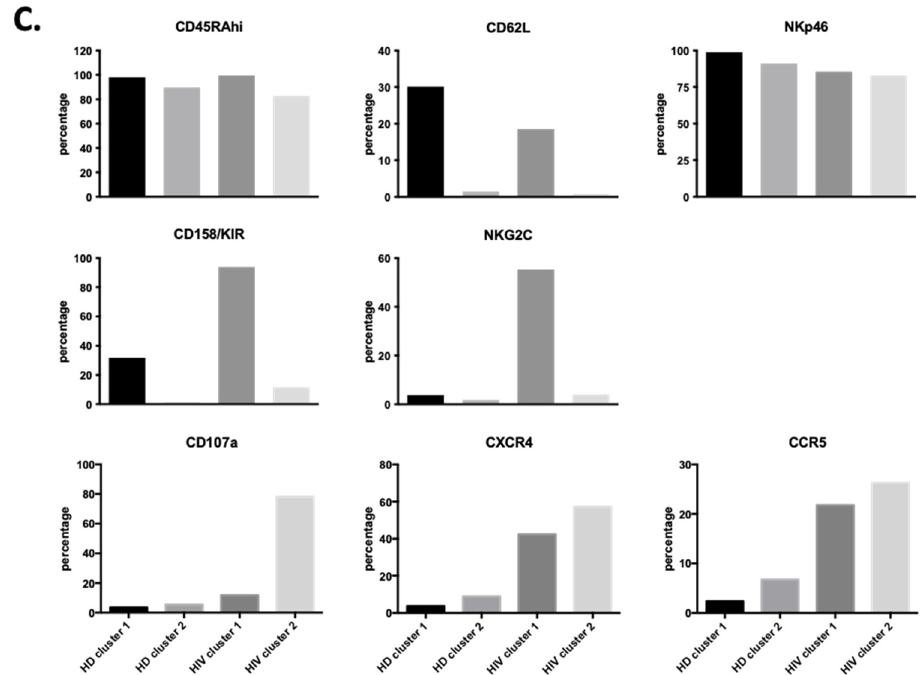
Figure 8. Cluster analysis on CD56negCD16 + NK cells by tSNE mapping in viremic patients. tSNE map was built from 2500 pre-gated CD56 neg CD16 + NK per sample (HD: n = 4, HIV-1: n = 4) based on 12 surface markers (supplementary Figure S6). ( A ) General tSNE map from all samples (left), HD samples (middle) and HIV-1 + samples (right) with identification of group-specific clusters. ( B ) tSNE replica showing clusters of each HIV-1 + patients. ( C ) Phenotypical characters of each cluster as identified in ( A ). Bar graphs represent the proportion of positive cells for each of the surface markers from the whole of events analyzed in each cluster.